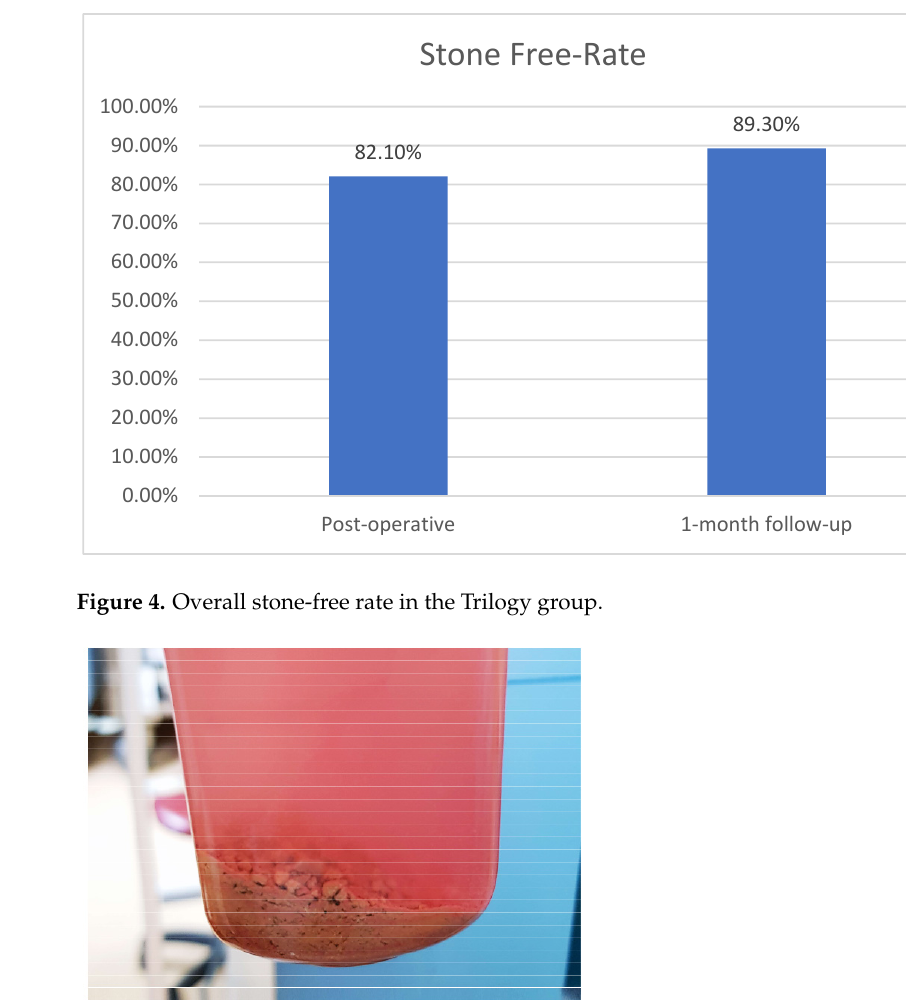
Figure 5. Stone fragments removed by the Trilogy device.